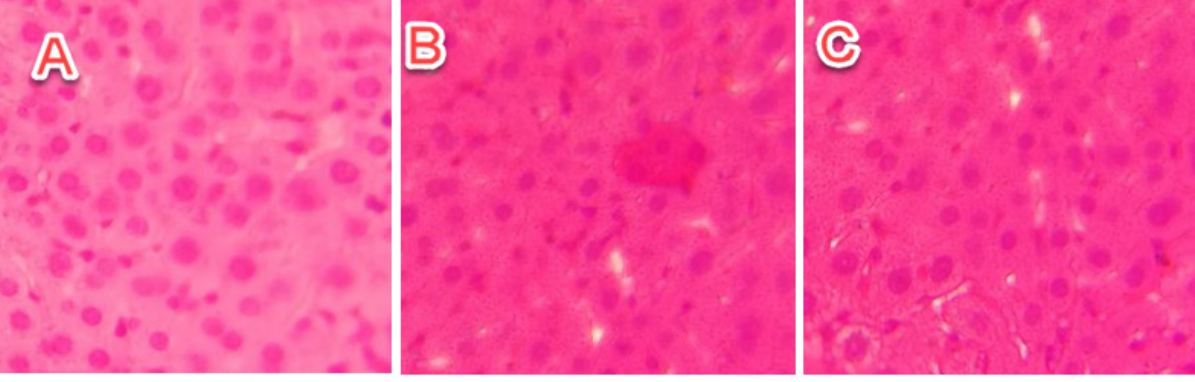
Figure 7 : The effect of the oral administration of aqueous extract of B. dioica roots on the liver tissue of treated groups with doses up to the maximum of 250 mg/kg (Section stained with H&E, x 40) (A) section of liver tissue of treated group with 62.5 mg/kg, (B) section of liver tissue of treated group with 125 mg/kg, (C) section of liver tissue of treated group with 250